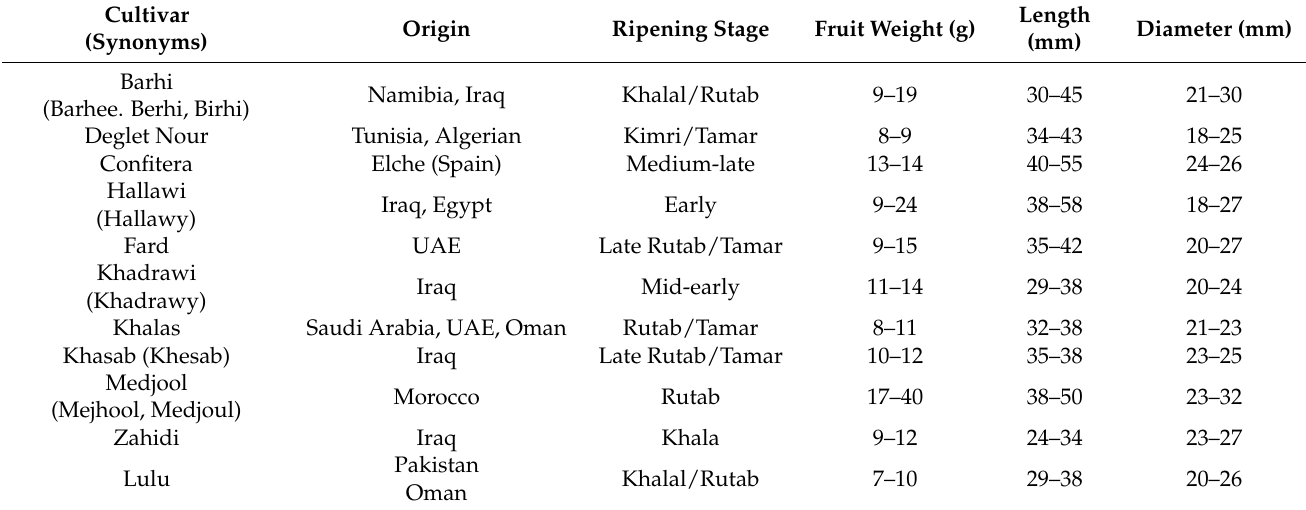
Table 2. Morphological characteristics of date fruits ( Phoenix dactylifera L.) from several